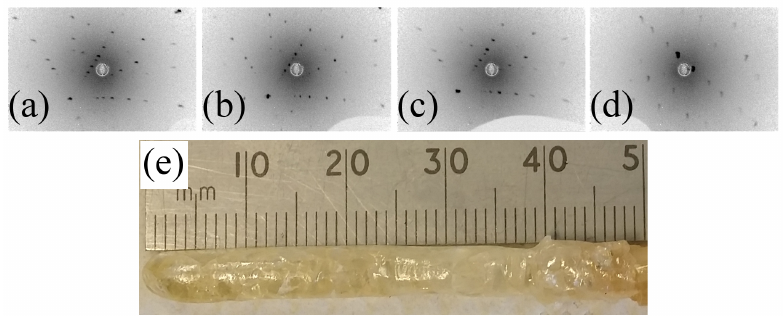
Figure 13. ( a – d ) X-ray Laue back reflection photograph taken on a facet of a crystal of Gd 2 Zr 2 O 7 crystal, taken along the crystal length at „ 10 mm intervals intervals, between the end (left) and the beginning (right) of the boule. The corresponding Laue patterns taken on the facet at 180 degrees are mirror images of these patterns; ( e ) Crystal boule of Gd 2 Zr 2 O 7 prepared in air using a growth rate of 15 mm/h from starting material with the pyrochlore structure,